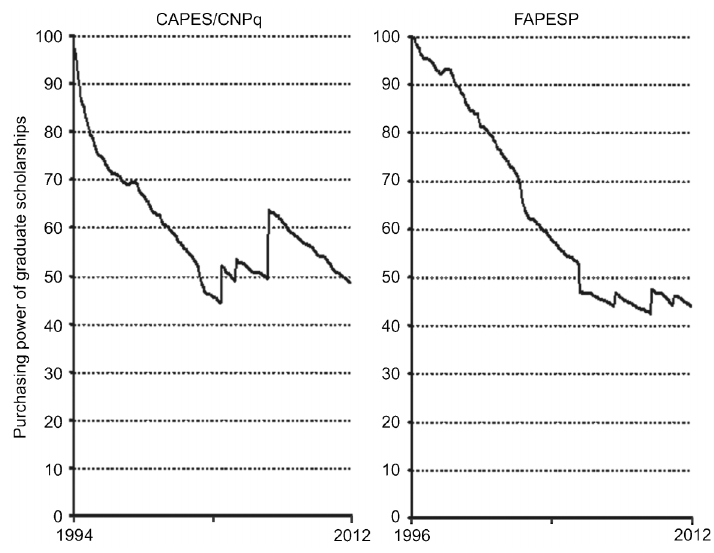
Figure 2. Purchasing power of CNPq and CAPES (left panel), and FAPESP (right panel) graduate scholarships between 1994 (CNPq and CAPES) or 1996 FAPESP and 2012, cal- culated using a National Consumer Price Index (IPCA) by the Economic Research Institute Foundation (FIPE), considering the scholar- ship values for December 1994 (CNPq and CAPES), or November 1996 (FAPESP) as 100% (updated from Ref. 13). Despite consid- erable inflation in the 1994-2006 period, schol- arships were frozen over this period. Thus, the loss of purchasing power pertains to the period without any monetary correction, from 1994 to 2004 for CNPq and CAPES, and from 1996 to 2006 for FAPESP. The criterion adopted for choosing the values of scholarships from CNPq and CAPES since 1994, and FAPESP since 1996, was the moment of correction in the period in